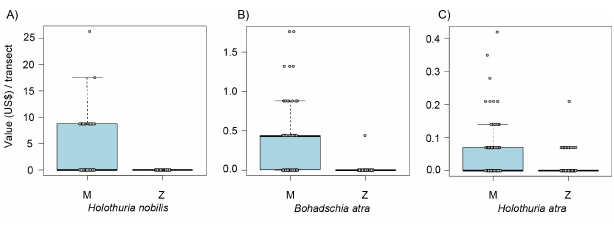
Fig. 4 . Values (US$) for each sea cucumber species in defined habitats per transect at Mayotte (M) and Zanzibar (Z), (A) Holothuria nobilis , (B) Bohadschia atra , and (C) H. atra . Each circle represents a sample, boxes show median (thick line), 25th and 75th percentile. Error bars are 95% confidence